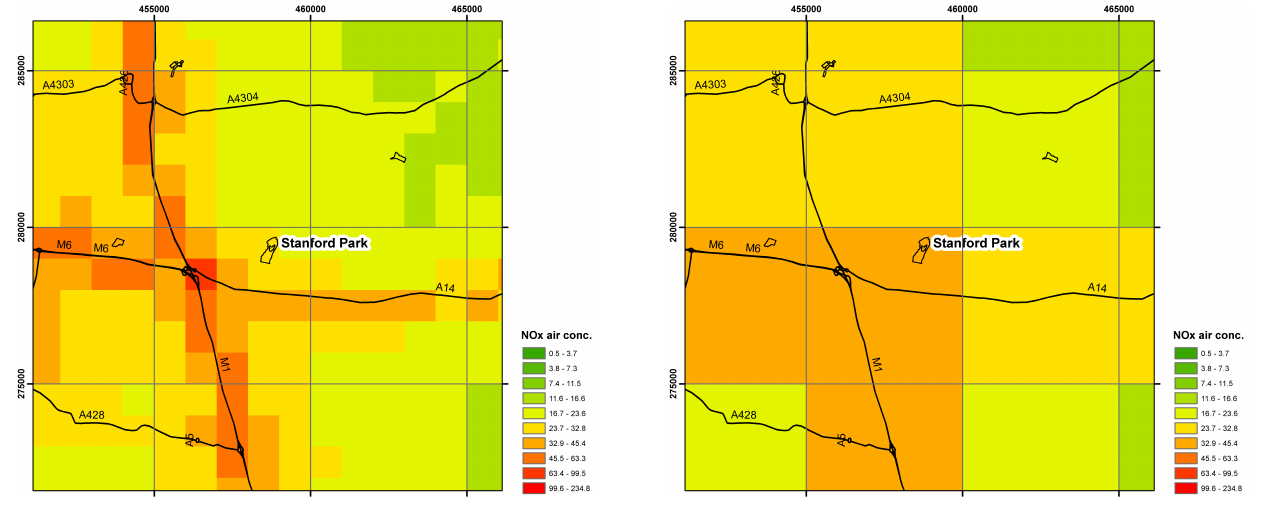
Fig. 3a. NO x air concentrations at Stanford Park SSSI (µgm − 3 ) with 1km grid resolution.